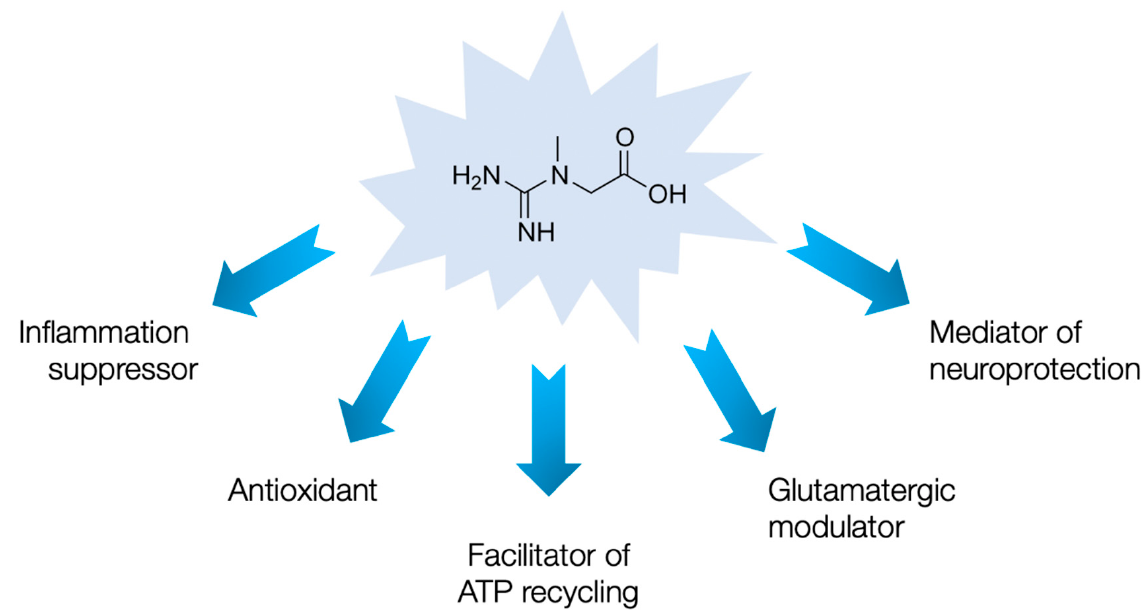
Figure 1. Possible mechanisms of creatine action in post-viral fatigue syndrome.